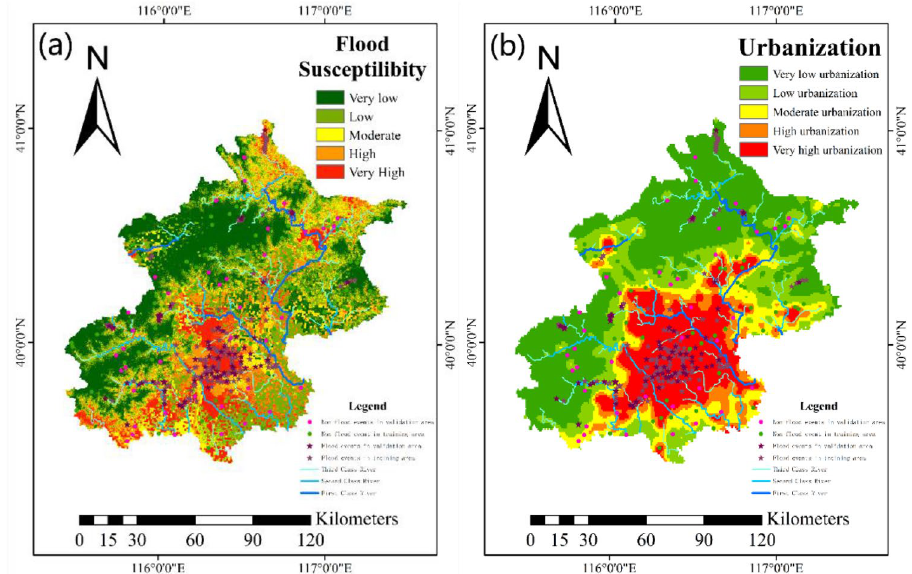
Figure 4. ( a ) Flood sensitivity map; ( b ) urbanization degree map (according to night light dataset) (we plotted the map using arcgis10.7. http:// www. esri. com/ sofwa re/ arcgis).